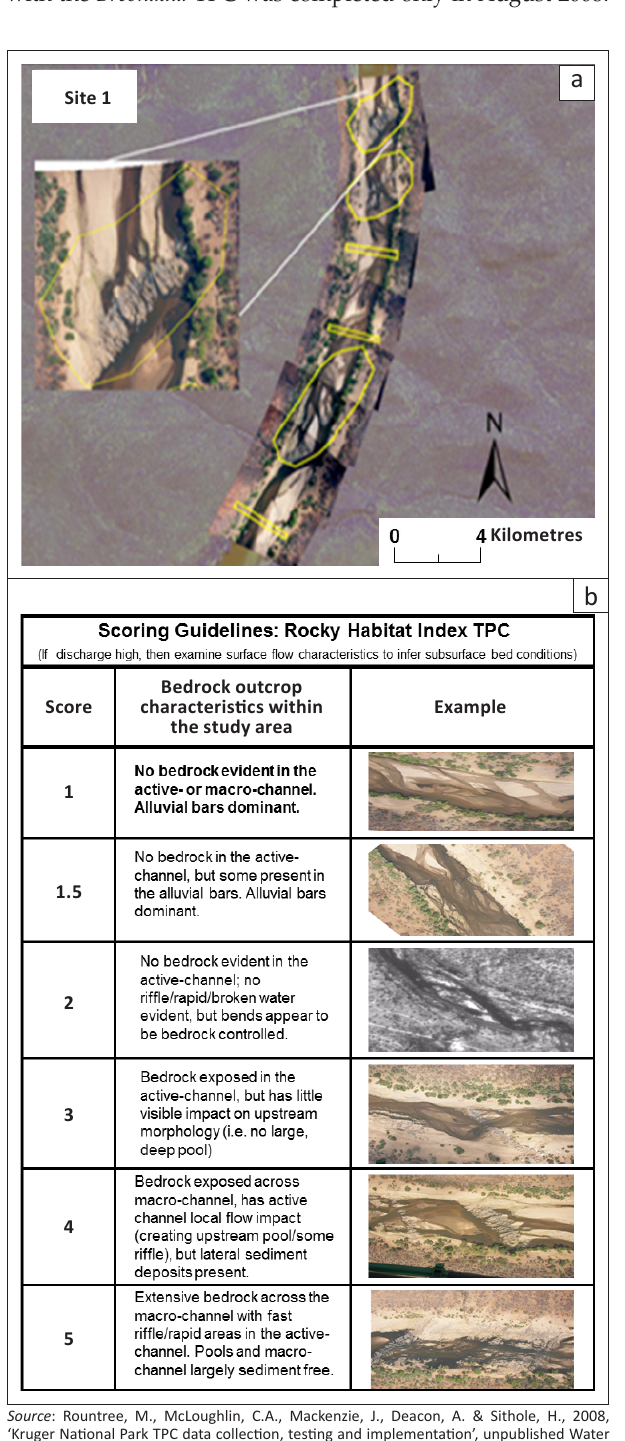
FIGURE 3: Methodology for the new geomorphology thresholds of potential concern concept. (a) Example of a site selection and demarcation, (b) Rocky Habitat Index scoring system, as tested on the Olifants